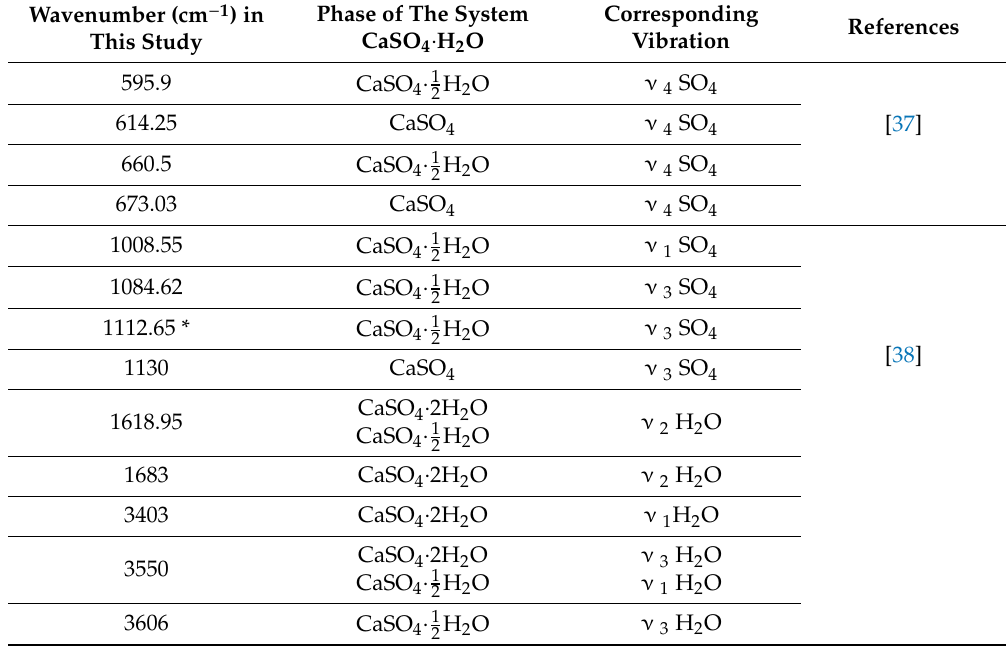
Table 3. Observed infrared fundamental modes in cm − 1 for sulphate anion and water molecule in CaSO 4 · 2H 2 O = Dehydrated; CaSO 4 · 1 H 2 O = Hemihydrate; CaSO 4 = Anhydrite, from specimen 2 recorded during both thermal